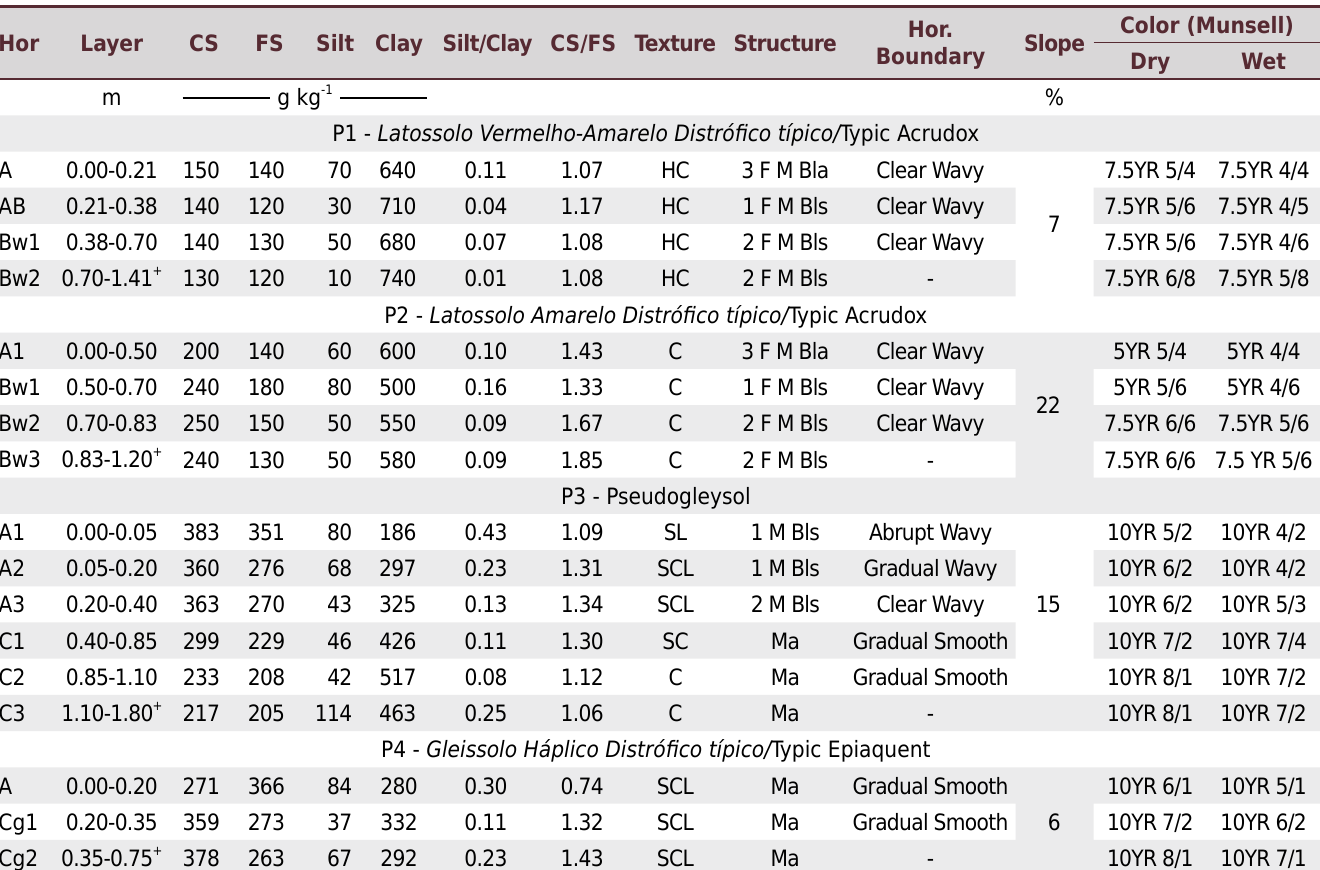
Table 1. Physical and morphological characterization of soils Hor Layer CS FS Silt Clay Silt/Clay CS/FS Texture